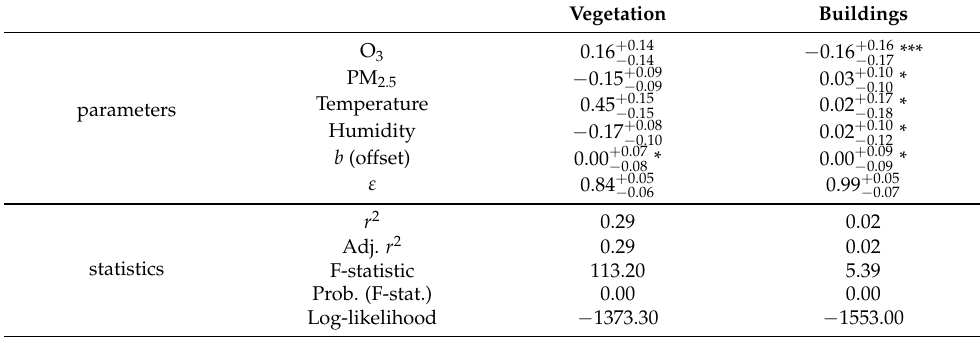
Table A1. Top: MCMC median and 3 σ uncertainty (including the full parameter covariance, derived from the MCMC posteriors of atmospheric coefficient parameters to model the NDVI values. Bottom: Model evaluation statistics for the maximum likelihood solution for vegetation and